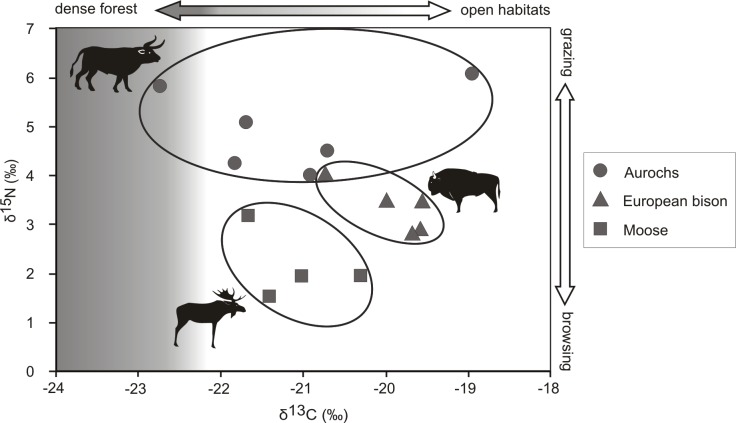
Stable δ13Ccoll and δ15Ncoll isotope values for moose (Alces alces), aurochs (Bos primigenius) and European bison (Bison bonasus) in Early Holocene in northern Europe.Shaded area denotes range of carbon isotope values characteristic for forest use. Ellipses are plotted in a way to include the extreme points of the range of measured isotopic values and to improve readability of the figure. The data used to generate the figure can be found in Table 1 and S1 Table.